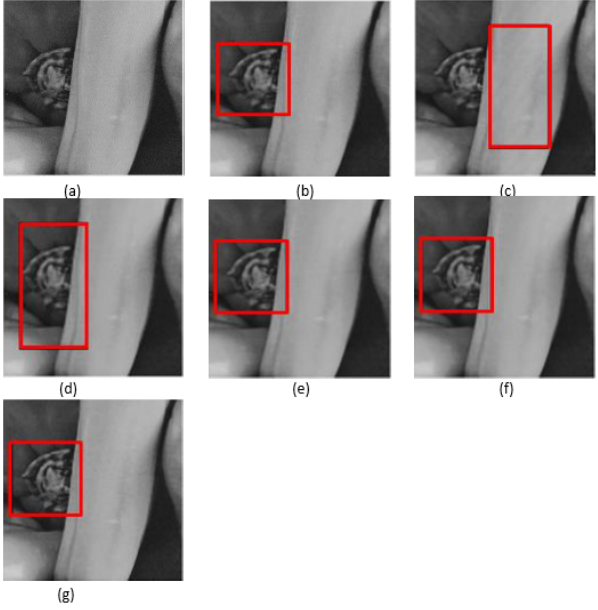
Fig. 9 Two-time reconstructed image Pepper using the six SR methods. (a) Input test image. (b) FCME. (c) NARM. (d) CSFI. (e) NeedFS. (f) IUIE. (g) Our method. red rectangles in Fig. 7(d) and Fig. 9(d). NeedFS produces evidently blurred textures, e.g., see the Artwall’s crack in Fig. 7(e) and the Pepper’s handle in Fig. 9(e). IUIE produces relatively clear HR images, but edge information is distorted, e.g., in the Artwall’s texture in Fig. 7(f), Lena’s hair in Fig.